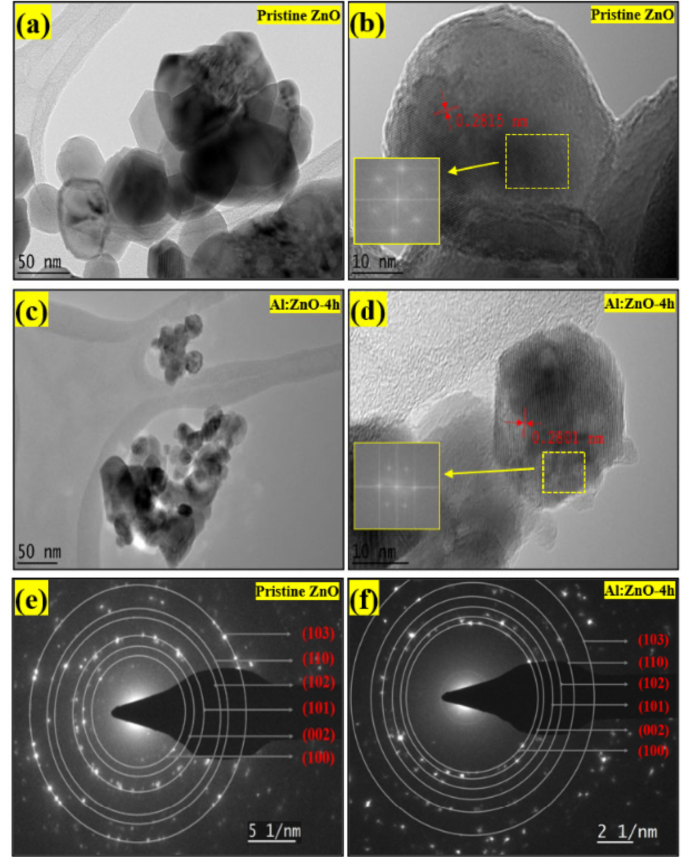
Figure 8. TEM micrograph at low magnification of: ( a ) pristine ZnO and ( c ) Al:ZnO-4 h. HRTEM micrograph with FFT analysis of: ( b ) pristine ZnO and ( d ) Al:ZnO-4 h. SAED pattern with indexing annotations of: ( e ) pristine ZnO and ( f ) Al:ZnO:4 h.